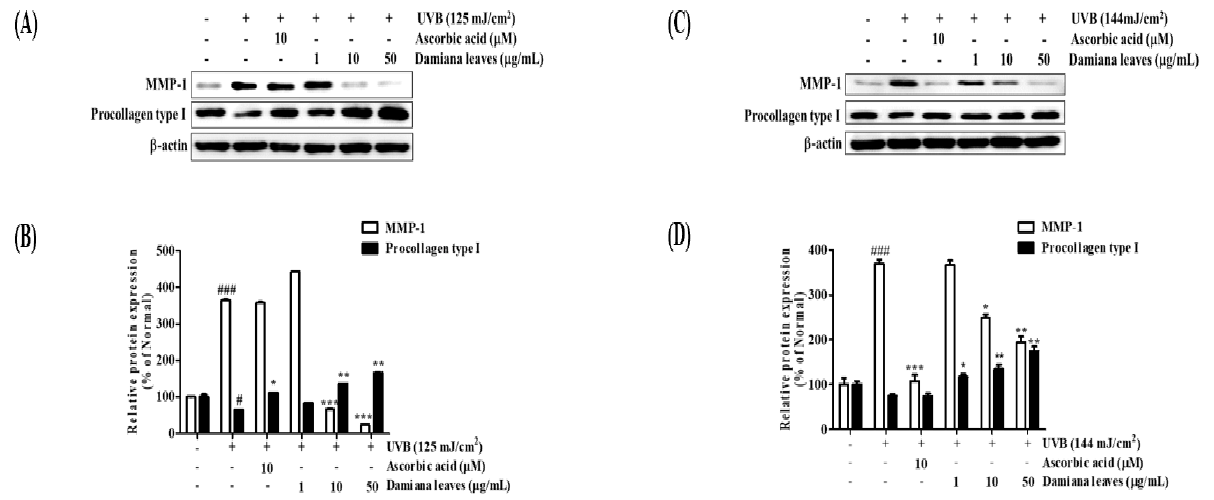
Figure 7. Effect of Damiana leaves extract on protein expression of MMP-1 and procollagen type I in UVB-irradiated HaCaT ( A , B ) and HDF ( C , D ) cells. Data are presented as the mean ± SD. # and * indicate significant differences from the non-irradiated control and UVB-treated groups, respectively. # and ### p < 0.05 and 0.001 vs. the non-treated group. *, ** and *** p < 0.05, 0.01, and 0.001 vs. the UVB-treated control,